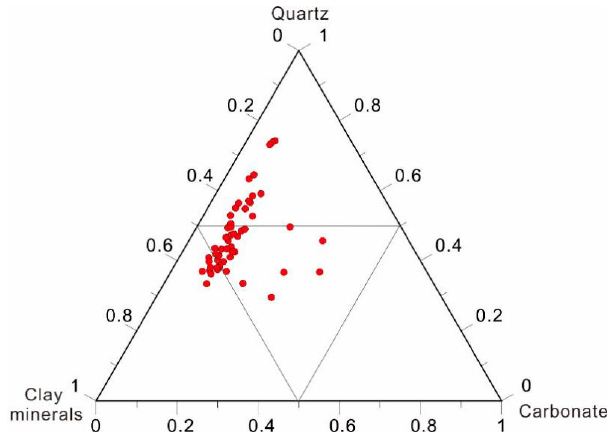
Figure 2. Ternary diagrams of mineral compositions in the Wufeng-Longmaxi Formation from Well A.